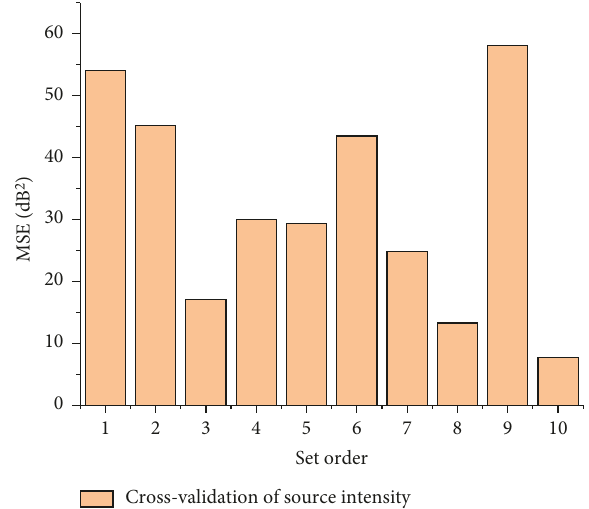
Figure 7: Cross validation of source intensity prediction.